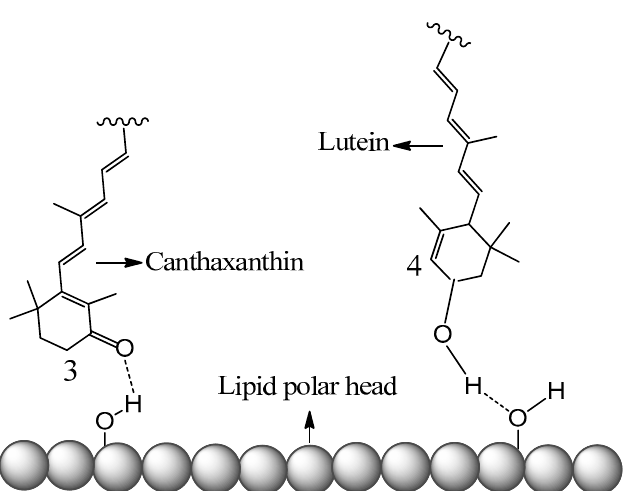
Figure 6. Schematic representation of canthaxanthin and lutein H-bonded to the surface of the lipid polar